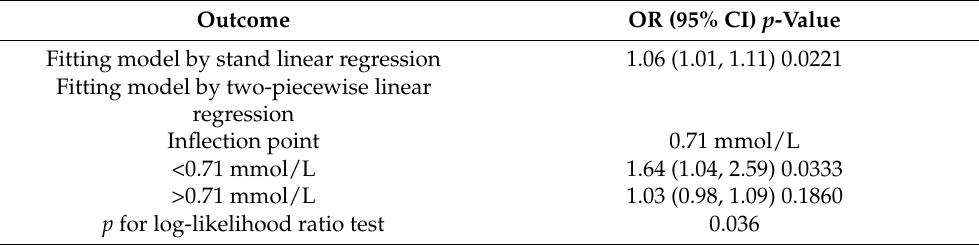
Table 4. Nonlinearity of preoperative serum phosphorus and